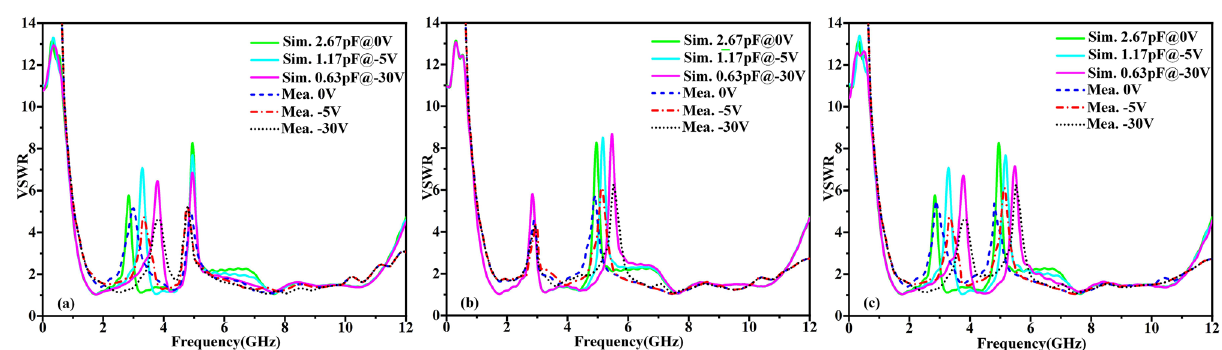
Figure 9. ( a ) Simulated and measured VSWR characteristics of structureG the voltage across the varactor diode ( a ) D 1 varies(D 2 , D 3 @0 V), ( b ) D 1 and D 2 varies simultaneously(D 2 , D 3 @0 V), ( c ) D 1 , D 2 and D 3 varies